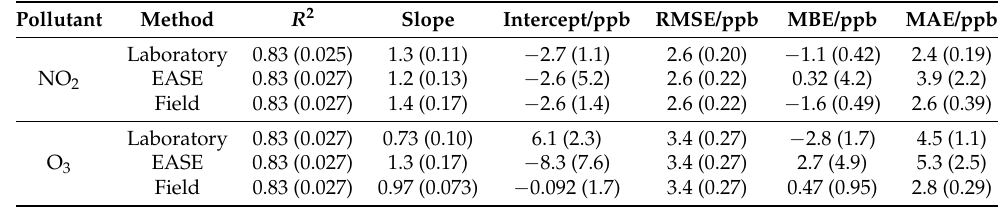
Table 4. Evaluation statistics for validation of the EC nodes with all calibration methods. Note that the statistics for the Laboratory calibration are calculated after the Field offsets, shown in Table A3, have been applied. All values are means over all EC nodes with their corresponding standard deviation shown in brackets.